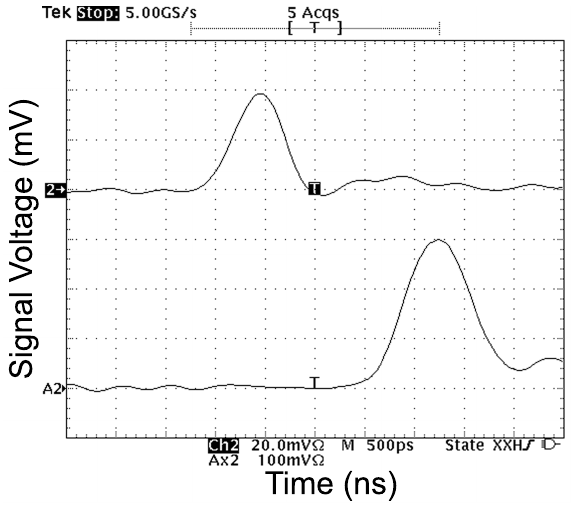
FIG. 18. Coherent synchrotron radiation measurements. The upper trace shows the signal from an X -band microwave detector placed at the end of the beam line, and the lower trace shows the laser photodiode signal. This demonstrates the shortness of the microwave radiation burst (below the response time of the oscilloscope). The horizontal scale is 500 ps (cid:1) div, and the vertical scale is 20 mV (cid:1) div for the upper trace and 100 mV (cid:1) div for the lower